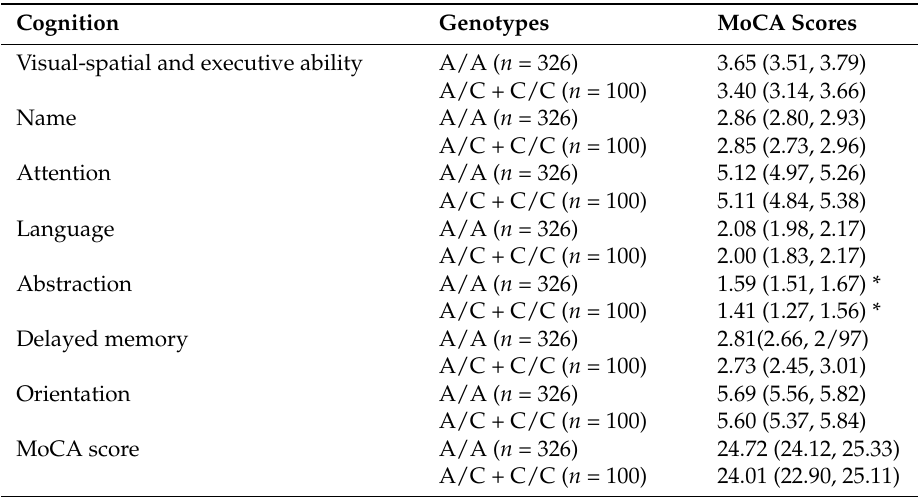
Table 4. MoCA scores by MTHFR A1298C